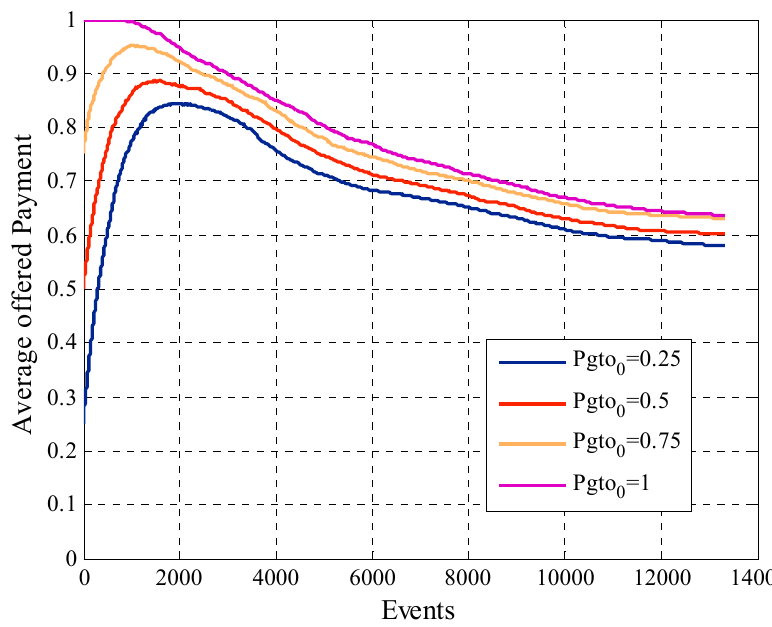
Figure 16. Average o ff ered payment for configurations with di ff erent values of Pgto 0 .